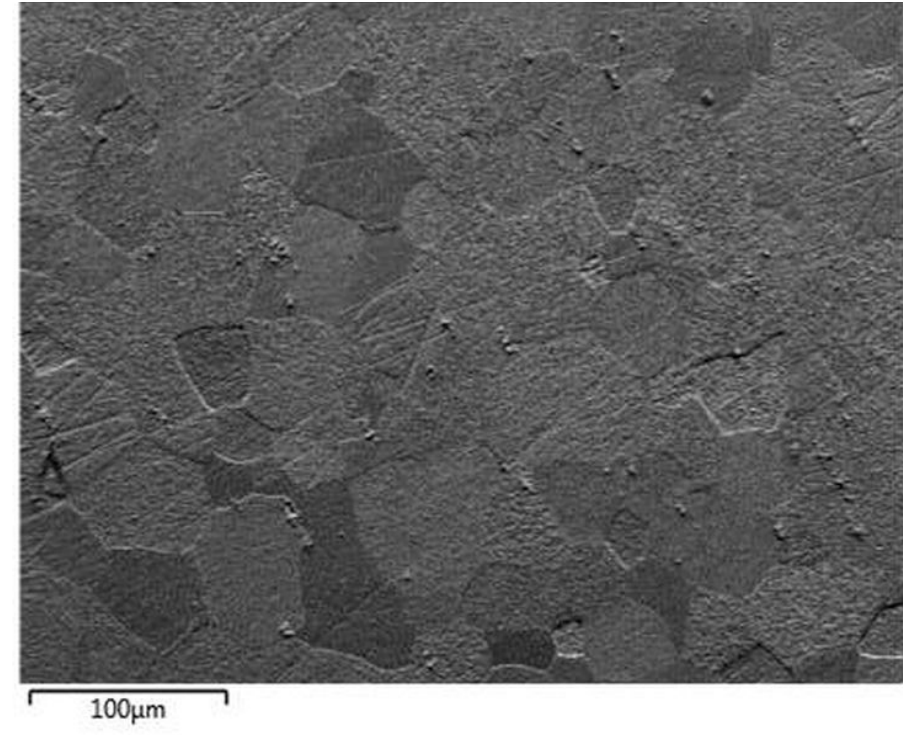
Figure 4. FSD mixed image of sputtered area of steel 1.4509 (AISI 441).